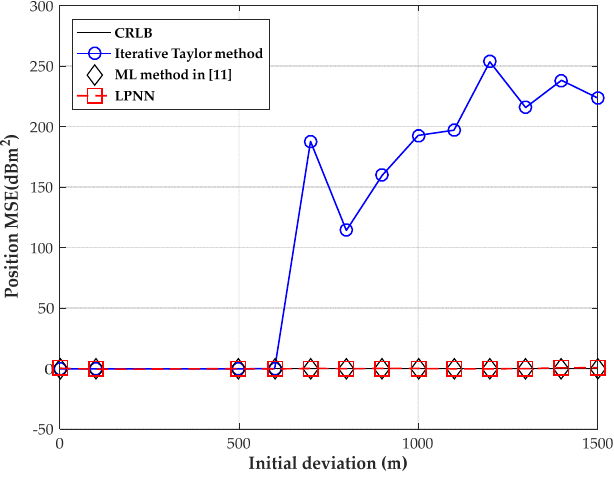
Figure 14. MSE versus level of initial deviation with the source position located at ( 30, − 20 )